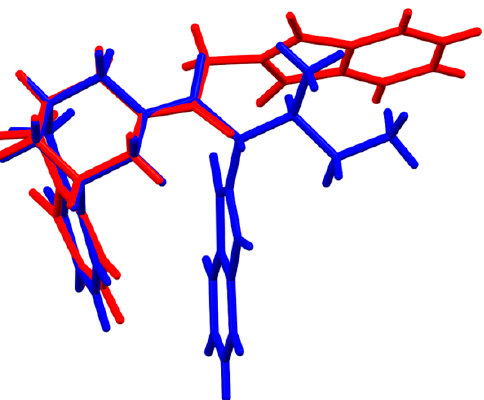
Figure 2. A comparison of conformations of 3A (red) and 3E (blue). The cytisine fragments were fitted one onto another.